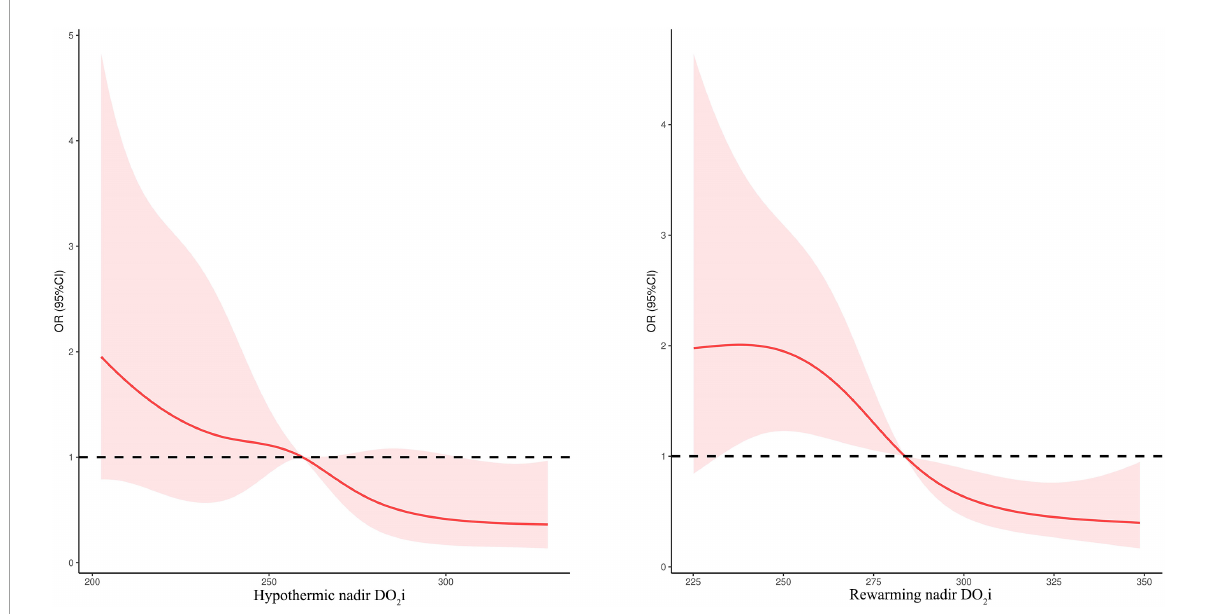
FIGURE4 Relationship between postoperative AKI and nadir DO 2 i during the hypothermic and rewarming